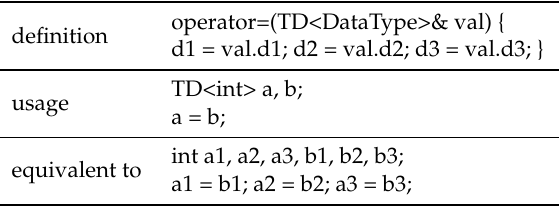
Table 2. Definition and functioning for the =